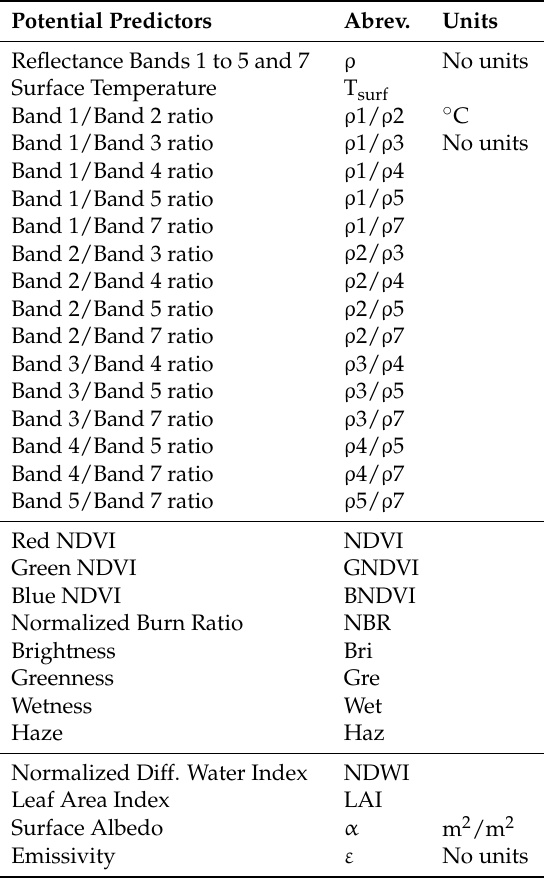
Table 4. Potential landsat indices calculated for this